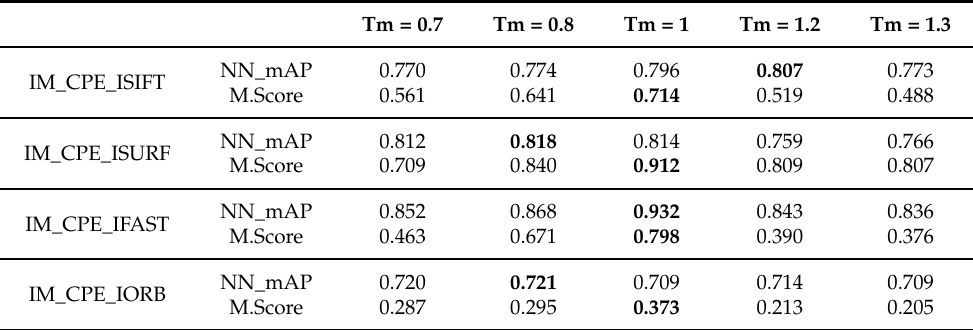
Table 1. Comparison of results of IM_CPE using four kinds of key points with various T M s in terms of NN_mAP and M.Score in ‘pioneer SLAM’